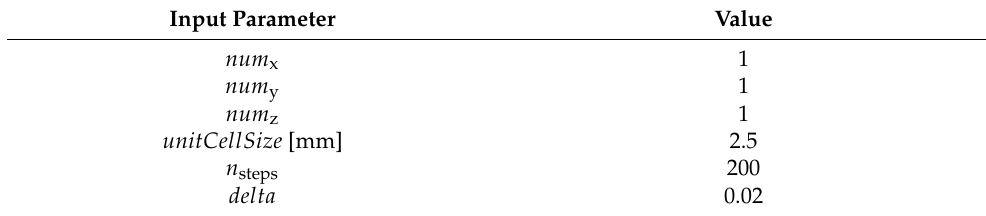
Table 3. Non-varying input parameters across all